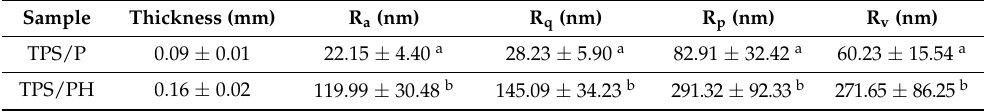
Table 1. Roughness parameters of thermoplastic starch